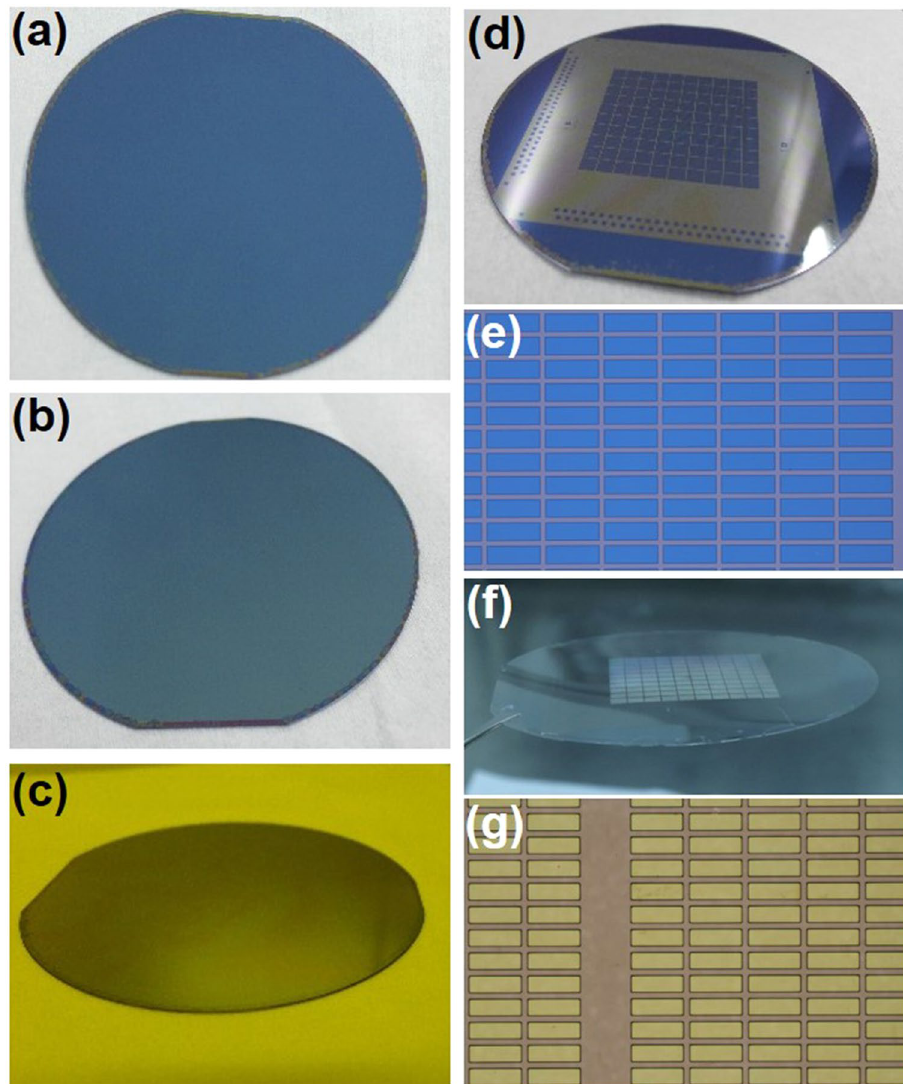
Figure 2. Optical images of the photolithography process. ( a ) CYTOP coated Si wafer, which was hard baked at 180 °C. ( b ) After SiO 2 deposition. ( c ) After spin coating of SU-8 3010 resist. ( d ) After photolithography and SiO 2 etching. ( e ) Typical zoom-in image of ( d ). The same process on PET ( f ) and corresponding zoom-in image ( g ). Also see Supporting information